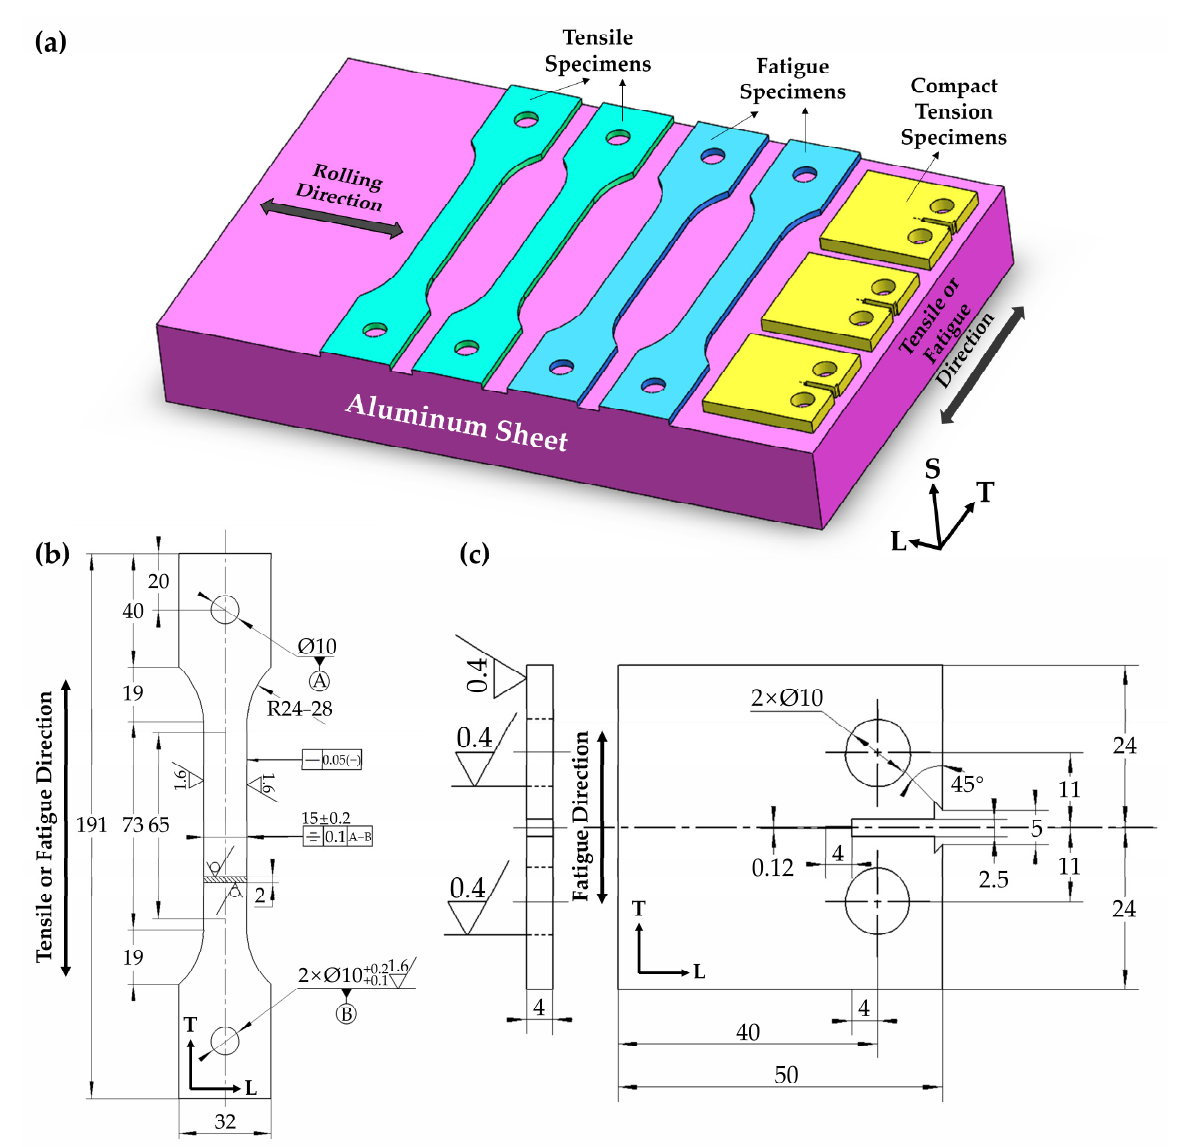
Figure 1. ( a ) The illustration of specimen processing and the dimensions of ( b ) the tensile and fatigue specimens and ( c ) the compact tension (CT) specimens (unit